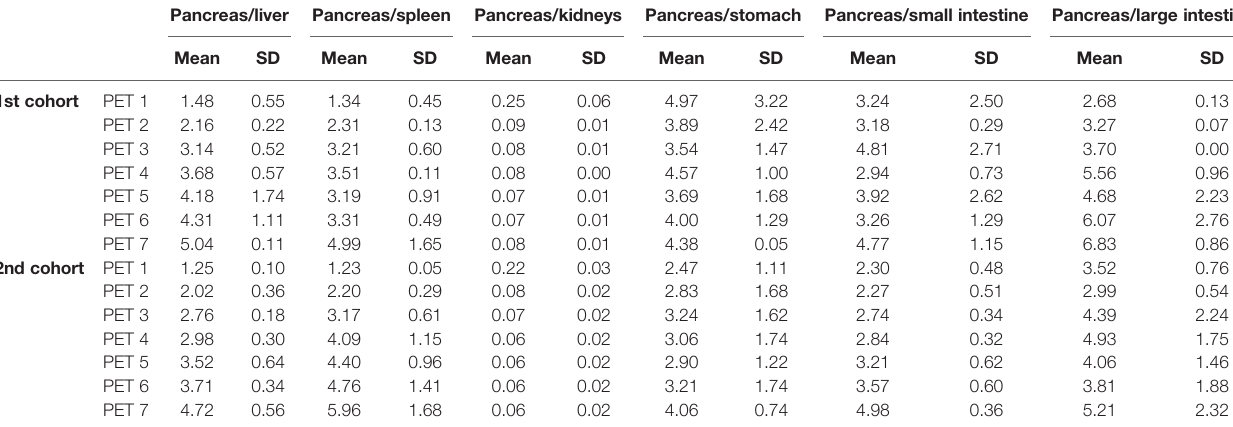
TABLE 2 | The pancreas-to-organ uptake ratios of [ 18 F]FB(ePEG12)12-exendin-4 ( 18 F-Ex4) in the fi rst and second cohorts. Pancreas/liver Pancreas/spleen Pancreas/kidneys Pancreas/stomach Pancreas/small intestine Pancreas/large intestine Mean SD Mean SD